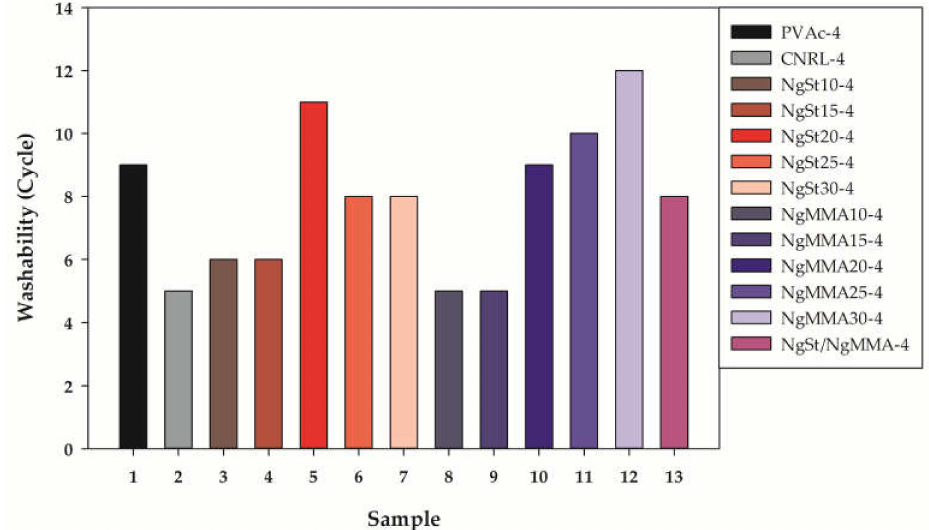
Figure 2. Washability of Various Types of Emulsion Paint Binders with Variations in Mono- mer